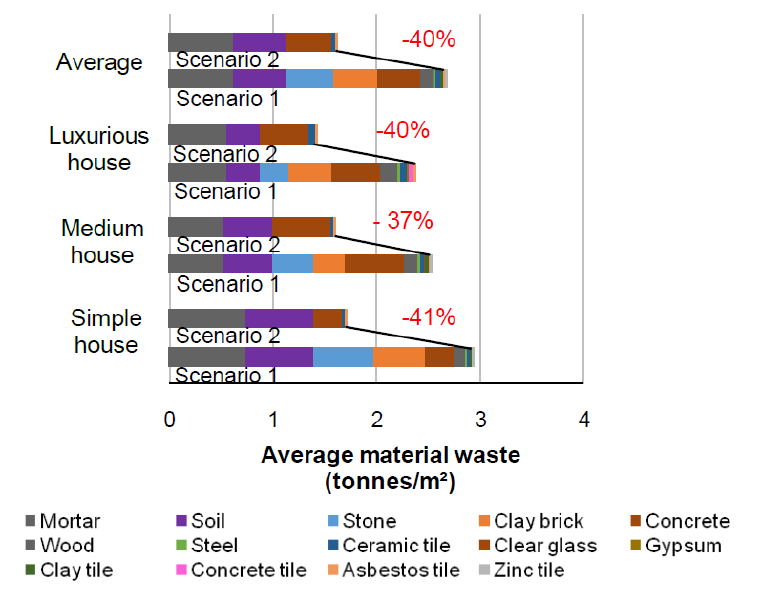
Figure 5. Average material